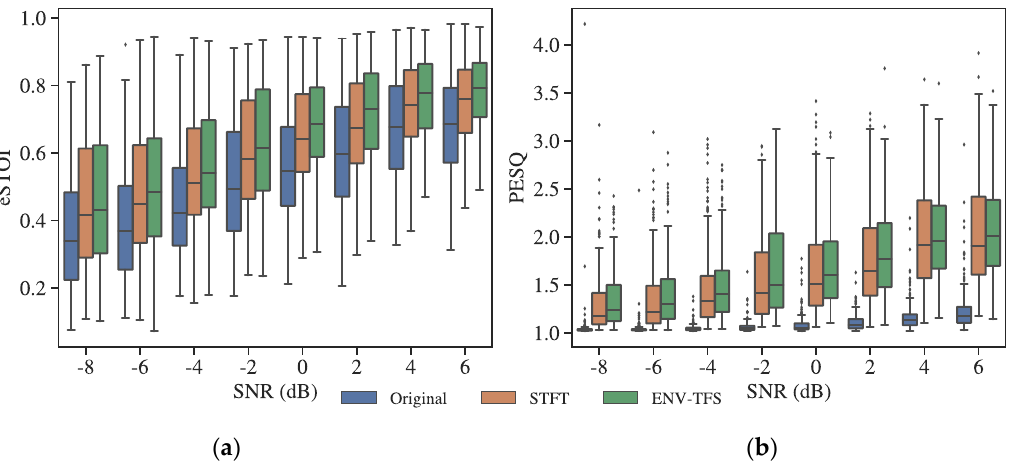
Figure 3. eSTOI ( a ) and PESQ ( b ) scores for eight SNR values (−8 dB to 6 dB) averaged over all noises of the test dataset. The box-whisker plots outline the objective results corresponding to the original noisy speech mixtures of the test dataset, the enhanced audio mixtures by the ENV-TFS system, and the enhanced audio mixtures by the STFT system.